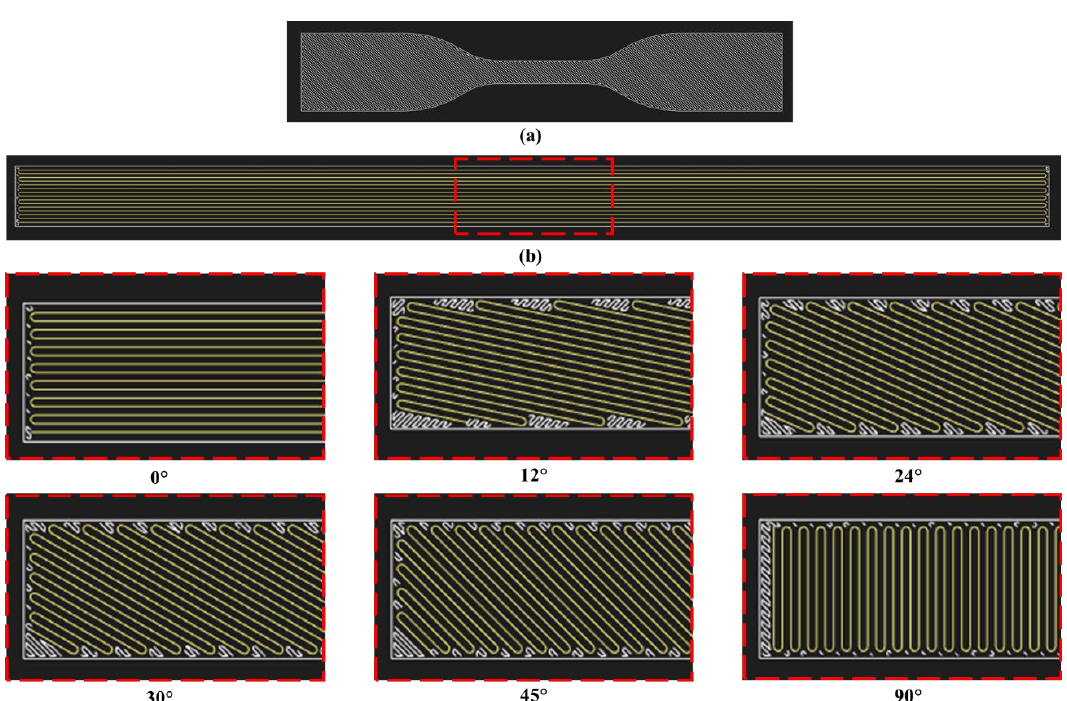
Figure 2. Internal view of 3D-printed layers ( a ) thermoplastic specimen ( b ) fiber orientations.